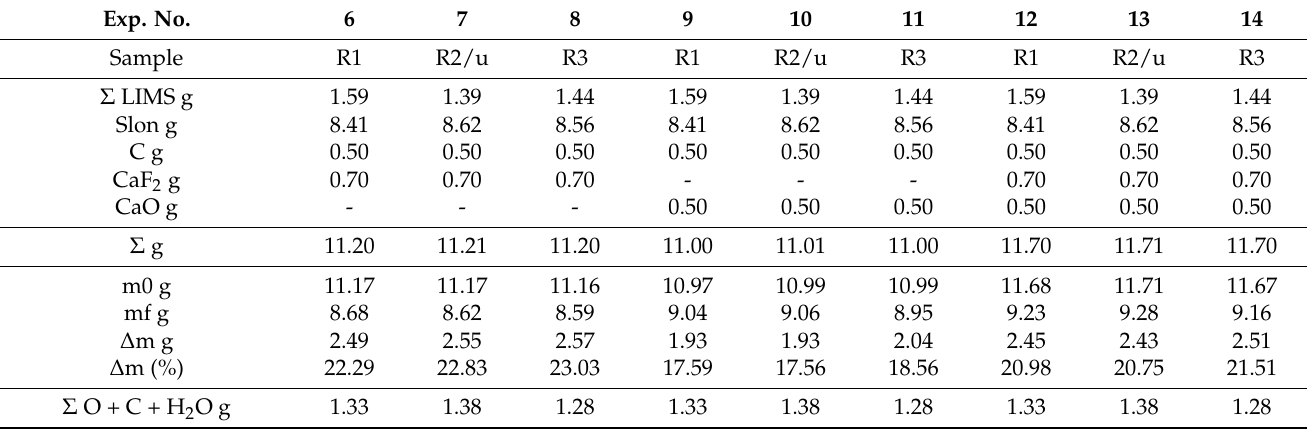
Table 6. Results of experiments 6–14 conducted up to 1500 °C with R1, R2/u, and R3 concentrates. Exp. No. Exp.